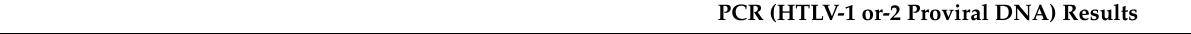
Table 1. Interpretation of all possible supplementary assays results combinations used to establish HTLV infection status in screening reactive